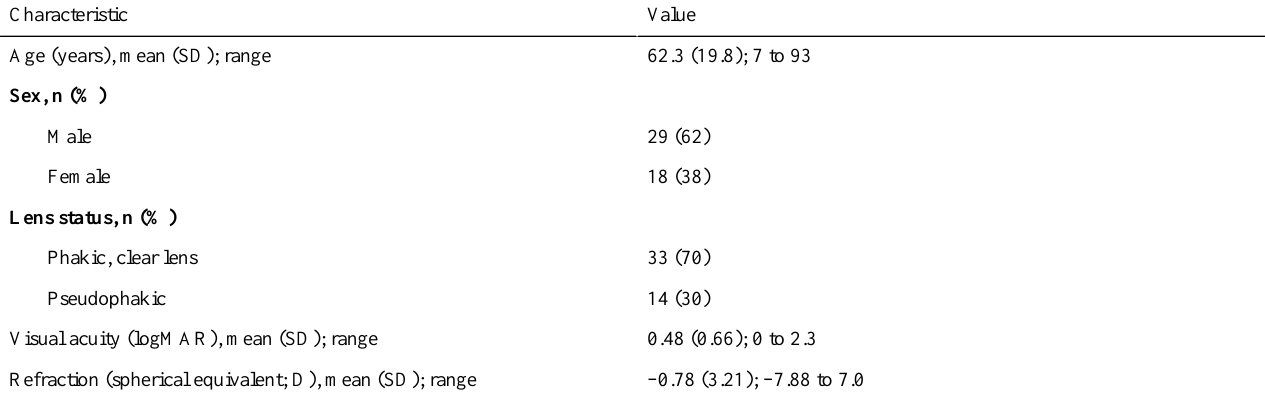
Table 1. Characteristics of the study sample (N=47).